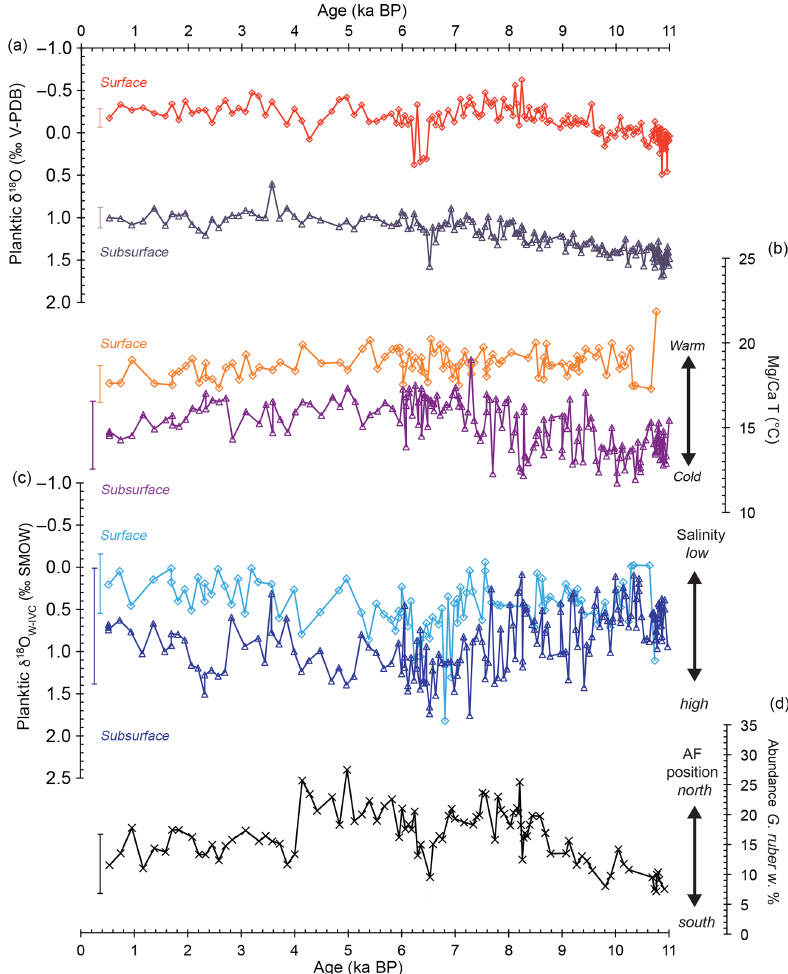
Figure 2. Results obtained from core GEOFAR KF16: (a) δ 18 O records from surface- ( G. ruber w.) (red diamonds; Schwab et al., 2012) and subsurface-dwelling planktonic foraminifera ( G. truncatulinoides ) (dark blue triangles; Repschläger et al., 2015), (b) Mg / Ca SST records from surface ( G. ruber w.) (orange diamonds) and subsurface ( G. truncatulinoides ) (violet triangles), (c) δ 18 O w-ivc records from surface- ( G. ruber w.) (light blue diamonds) and subsurface ( G. truncatulinoides )-dwelling planktonic foraminifera (blue triangles), (d) G. ruber w. abundance (Weinelt et al., 2015) as indicator for the AF position (black crosses). Grey bars indicate the 2 σ SD for all